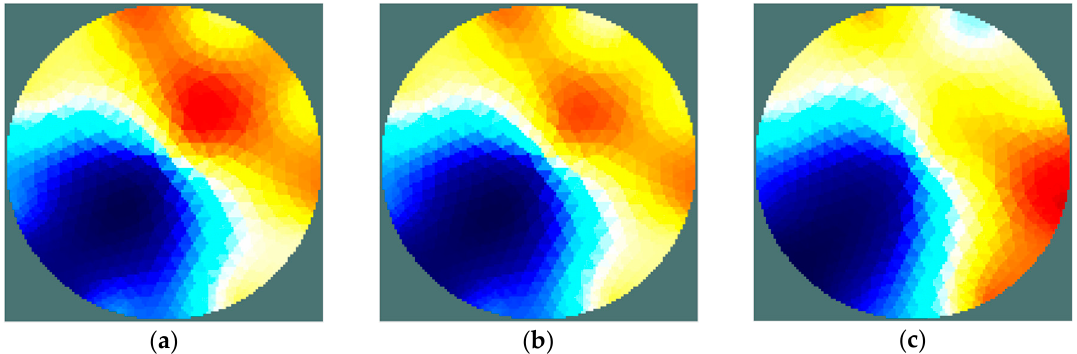
Figure 12. Case 1: Chokeberry with water content of 69.0% / 35.2%. Reconstructed images for voltage stimulation of 100 Hz ( a ), 1 kHz ( b ), 10 kHz ( c ).